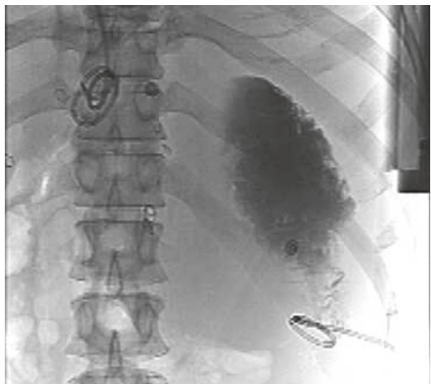
Figure 6: After US-guided percutaneous puncture drainage of pancreatic pseudocyst, X-ray showing drainage tube was in the right place.